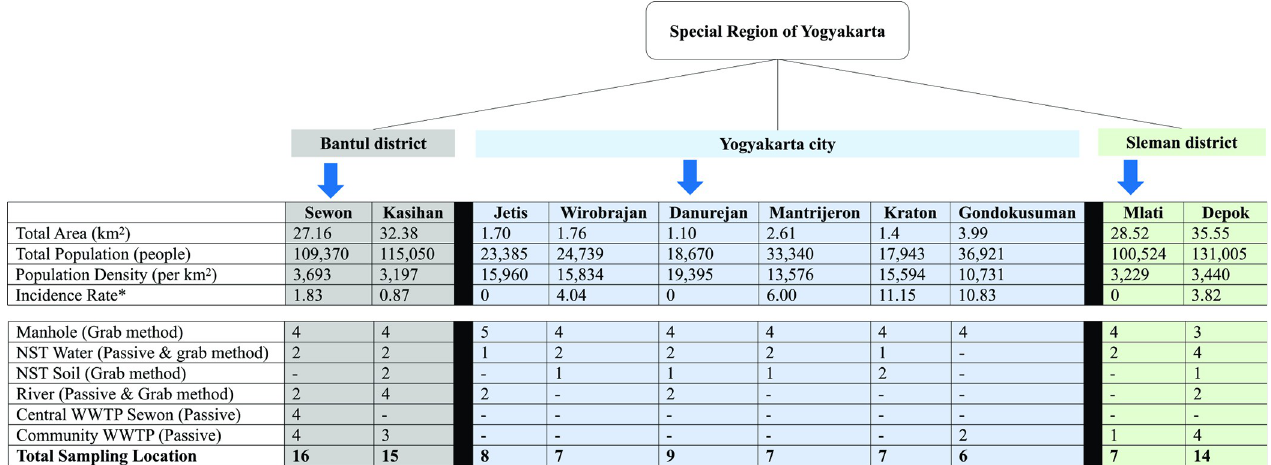
Fig 1. Flowchart of sample strategy. We selected ten sub-districts from three out of five districts in Special region of Yogyakarta Province (Yogyakarta city, Bantul, and Sleman districts). Samples from three sub-districts were taken weekly (identified by blue arrows), while others were taken fortnightly. Detailed type and number of samples in each sub-district are illustrated in the